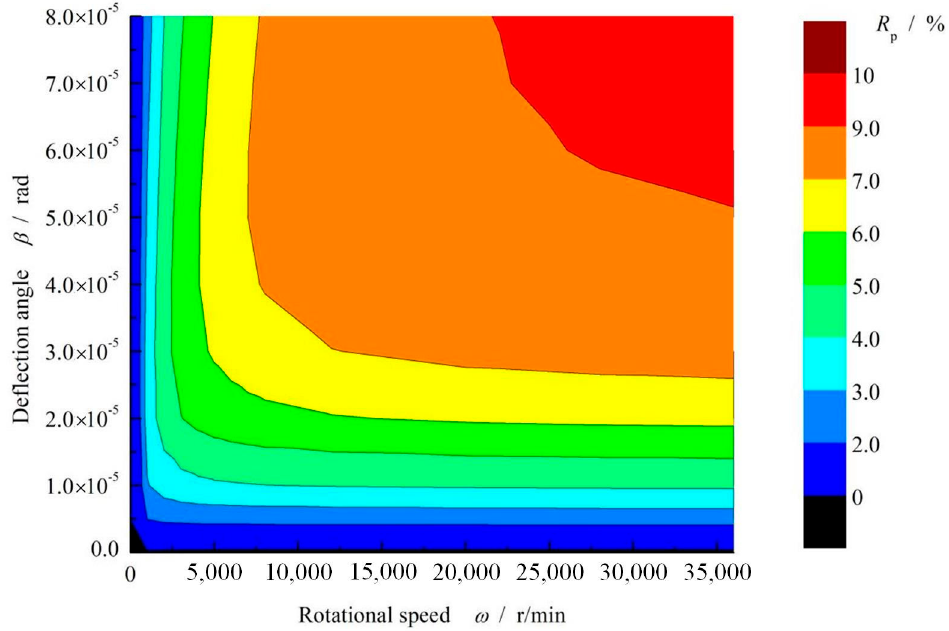
Figure 19. Selection interval diagram of dimensionless mean pressure increase rate. ( p i = 0.2 MPa, T in = 580 K, T out = 380 K, p s = 0.03 MPa).